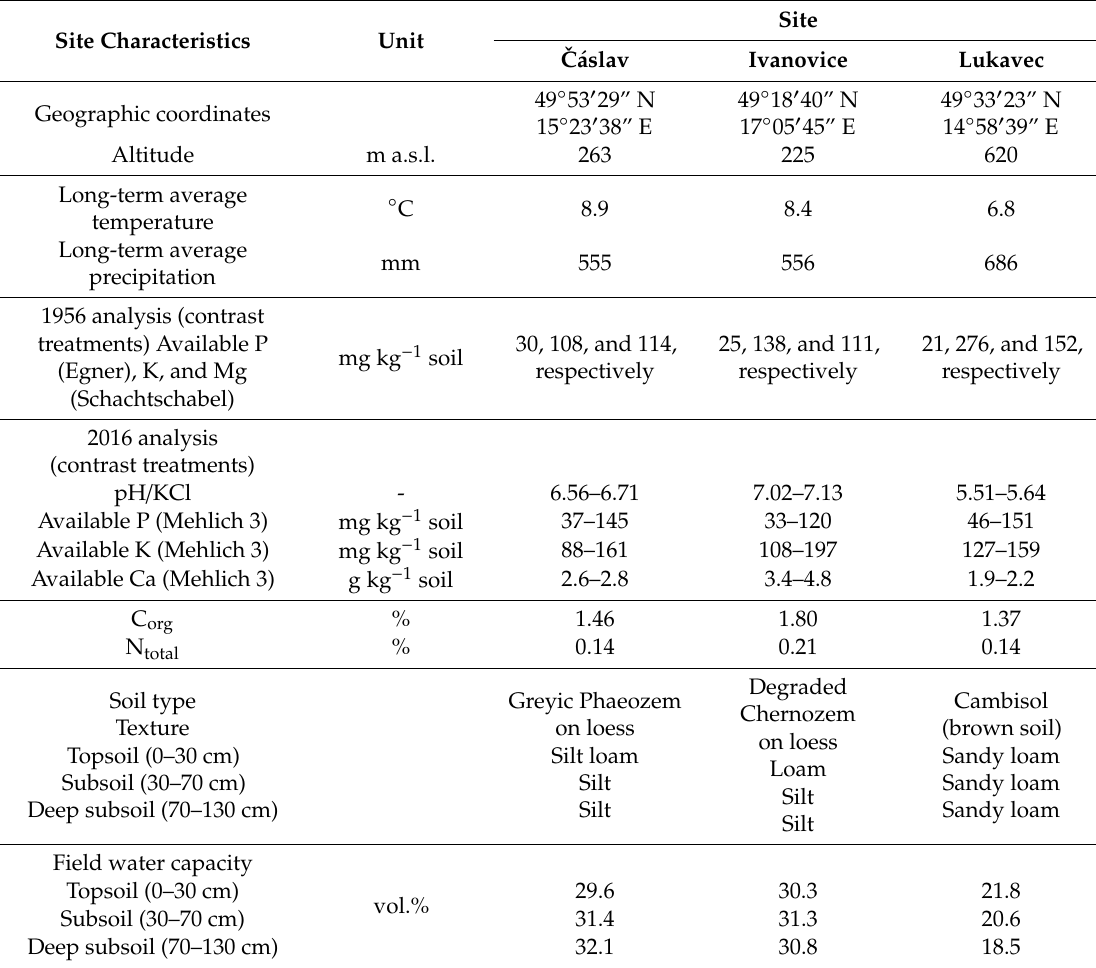
Table A1. Basic conditions of the experimental